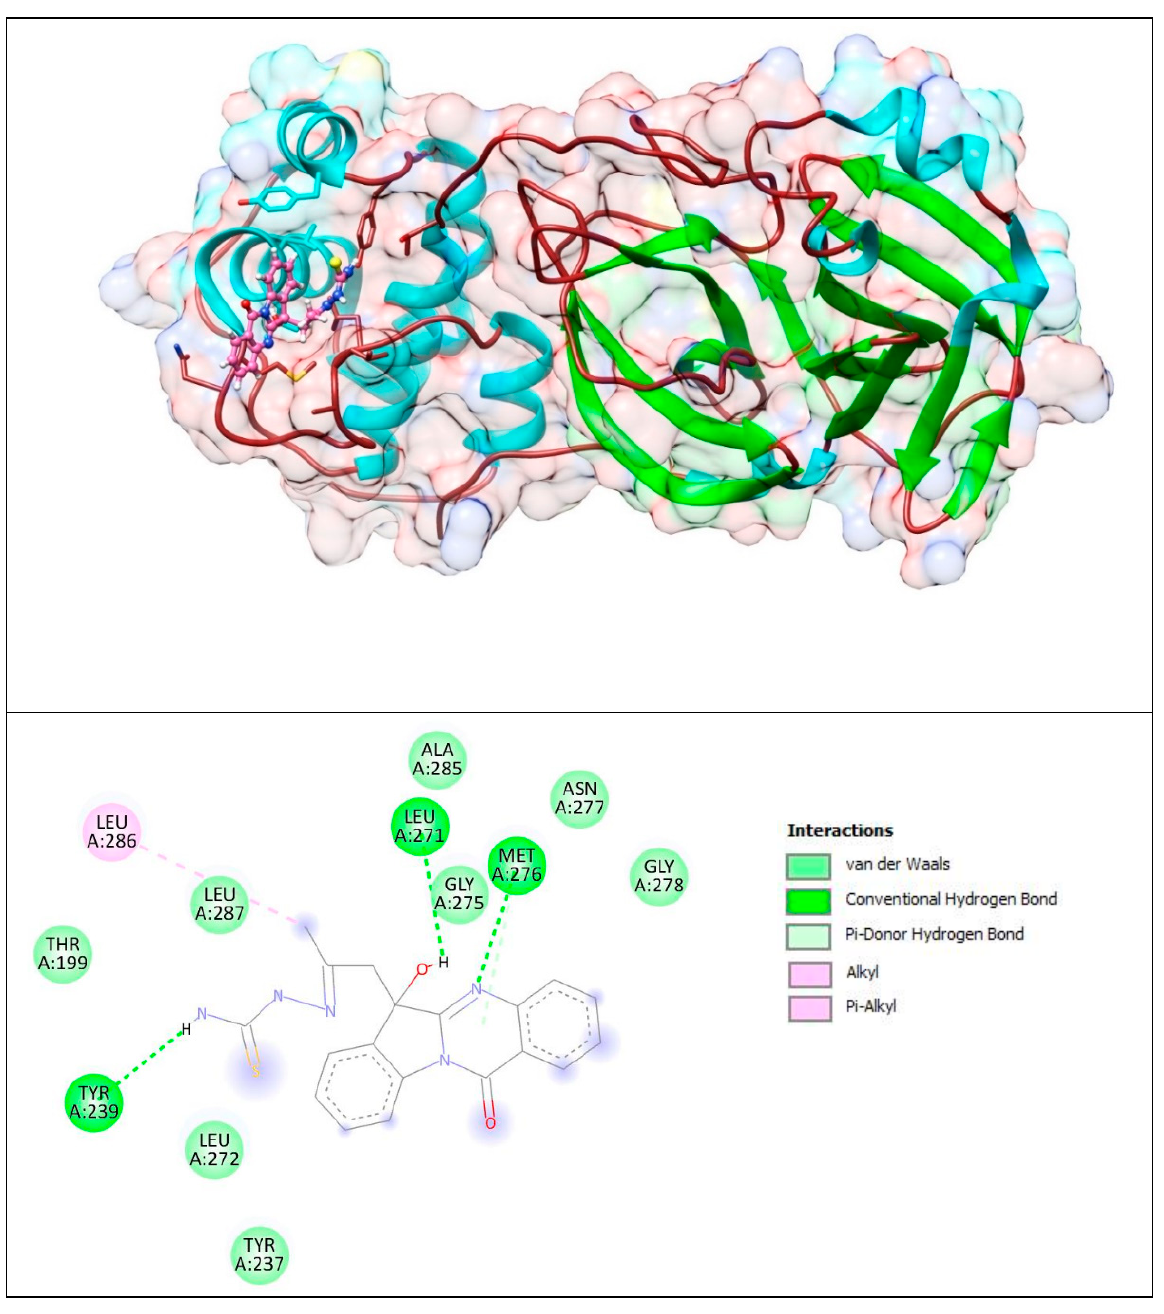
Figure 14. Complex of Mpro with PAA-TSC. The upper panel shows a 3D model of Mpro with a binding site (cavity) on its surface PAA-TSC. The lower panel shows the binding mode of PAA-TSC with the amino acid residues of Mpro. Figure was created with UCSF Chimera ( upper panel ) and BIOVIA Discovery Studio Visualiser ( lower panel ) and shows the best docking pose of PAA-TSC on Mpro. We can also see where the PAA-TSC is placed on the Mpro surface and a general view of the complex of Mpro (green–cyan–brown) with PAA-TSC (pink). The secondary structure of the protease behind the molecular surface (created with 90% transparency for better presentation of the molecule) is also